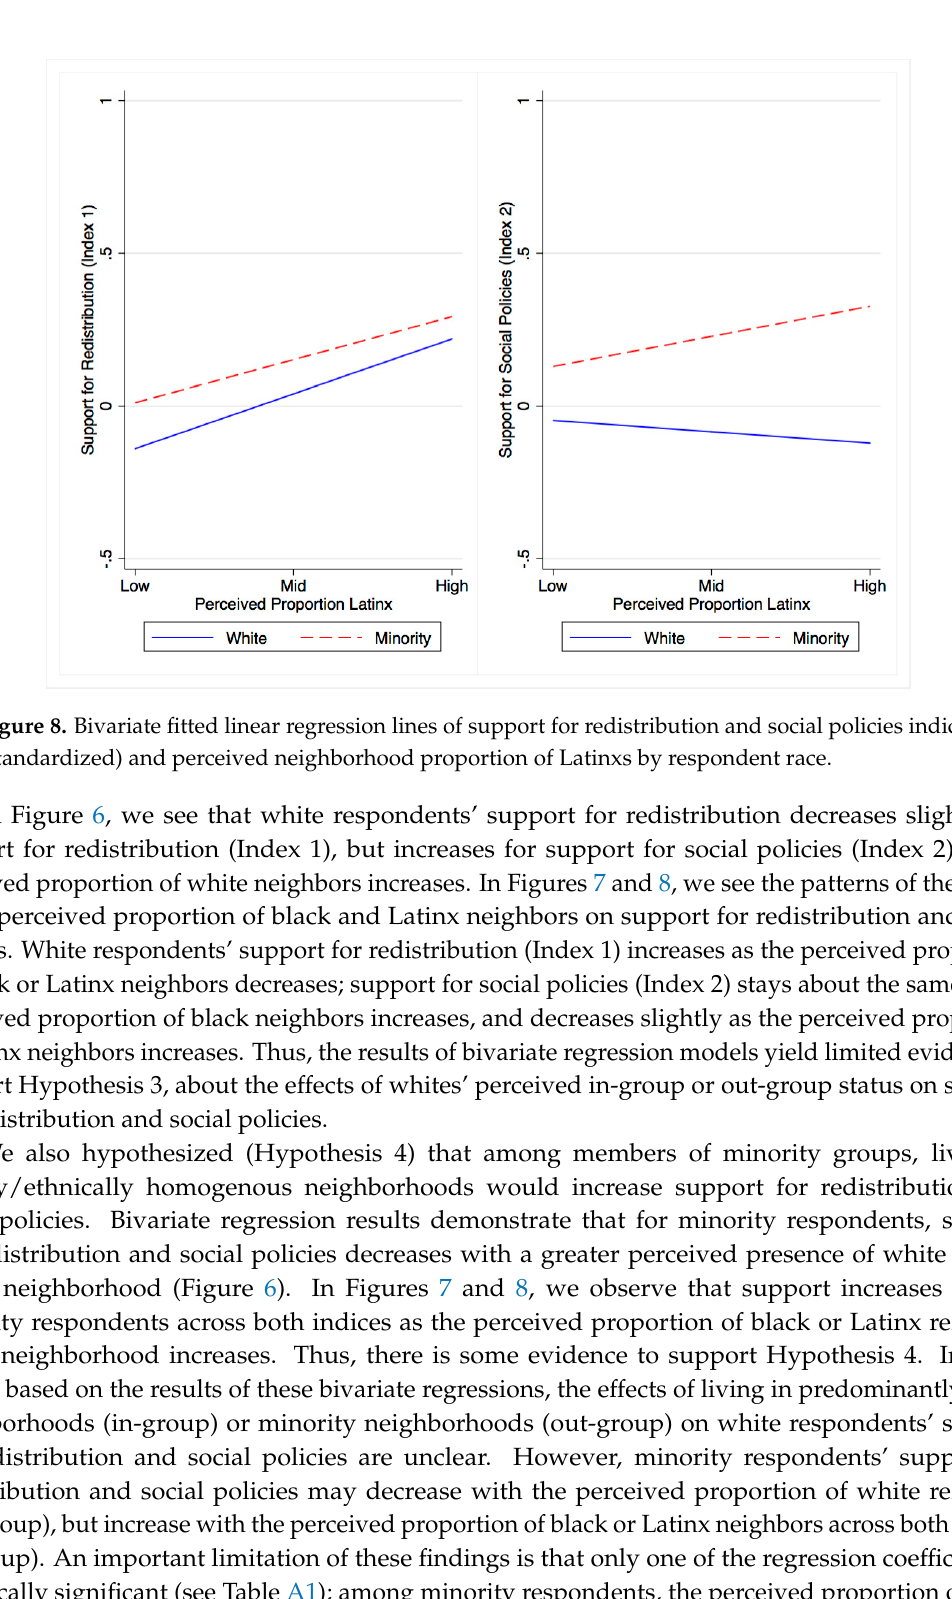
Figure 7. Bivariate fitted linear regression lines of support for redistribution and social policies indices (standardized) and perceived neighborhood proportion of blacks by respondent race.